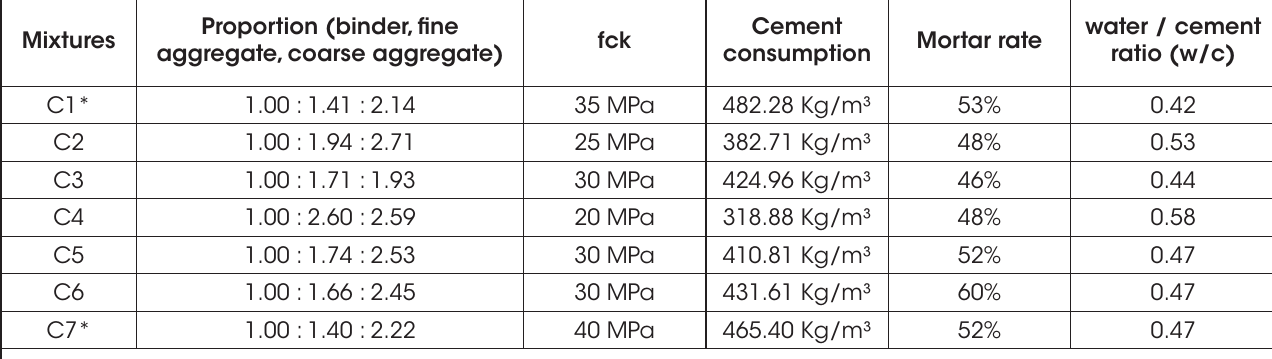
Concrete compositions)